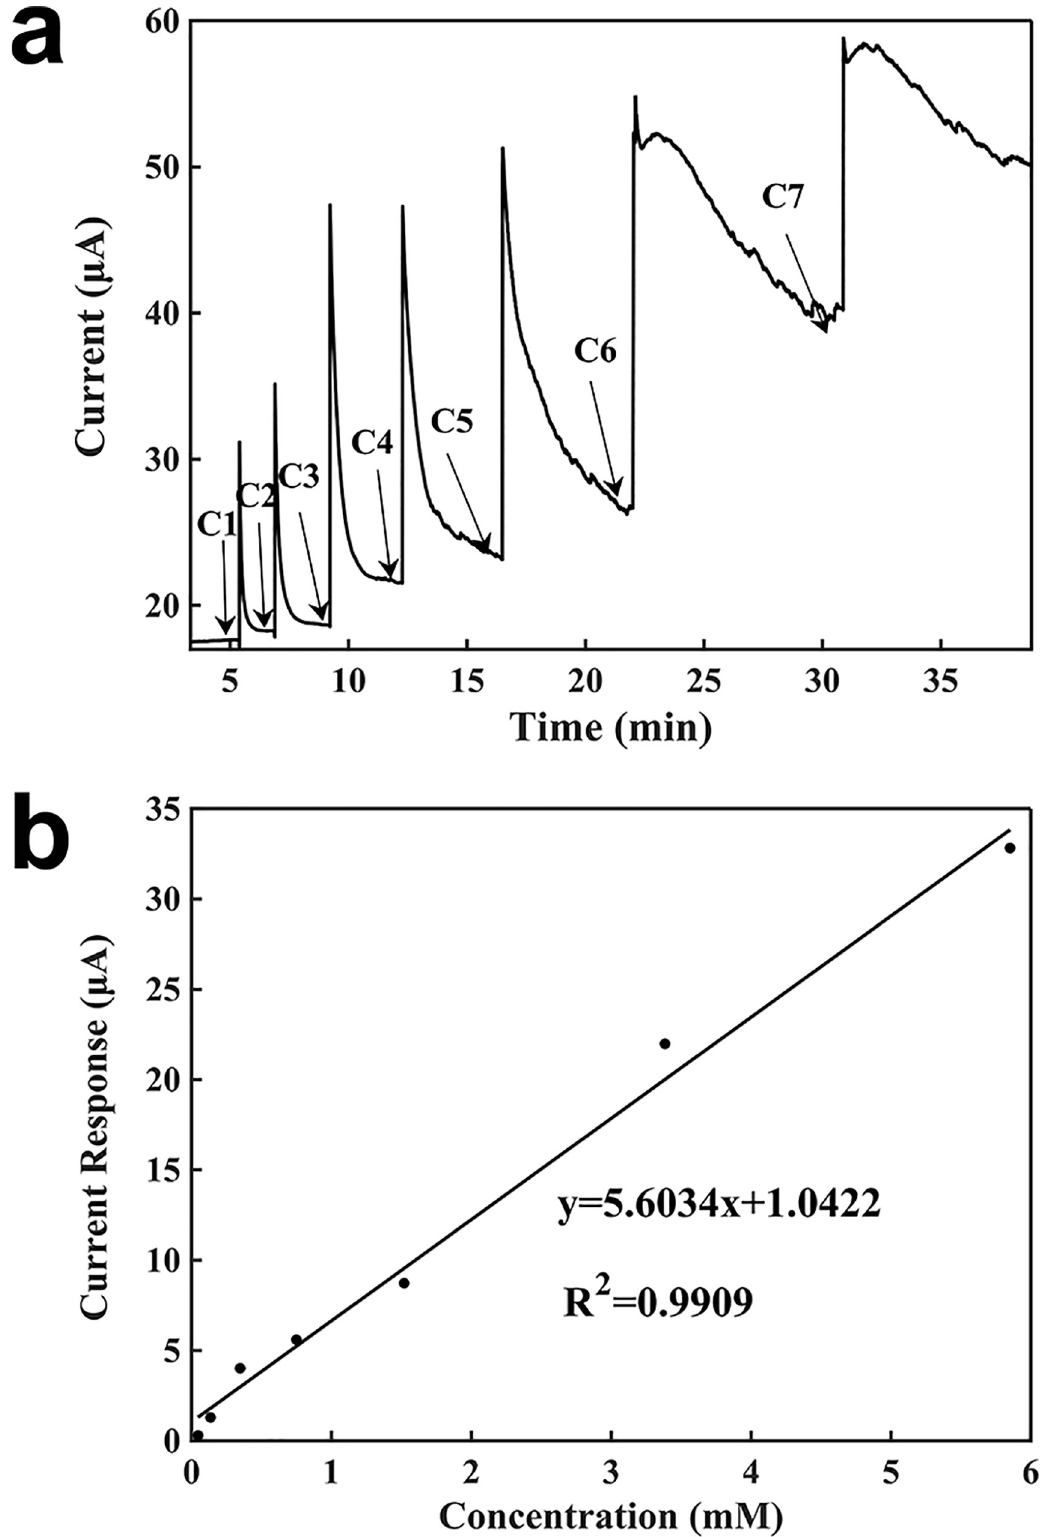
Fig 4. Characterization of the sensor for the detection of H 2 O 2 using a potentiostat. (a) Current-verses-time response curve upon the additions of H 2 O 2 . C1: 0.04762mM, C2: 0.08875mM, C3: 0.21146mM, C4: 0.40217 mM, C5: 0.77000 mM, C6: 1.86462 mM, C7: 2.46724 mM. (b) Calibration curve for the detection of H 2 O 2 . https://doi.org/10.1371/journal.pone.0212943.g004 PLOS ONE | https://doi.org/10.1371/journal.pone.0212943 March 6,